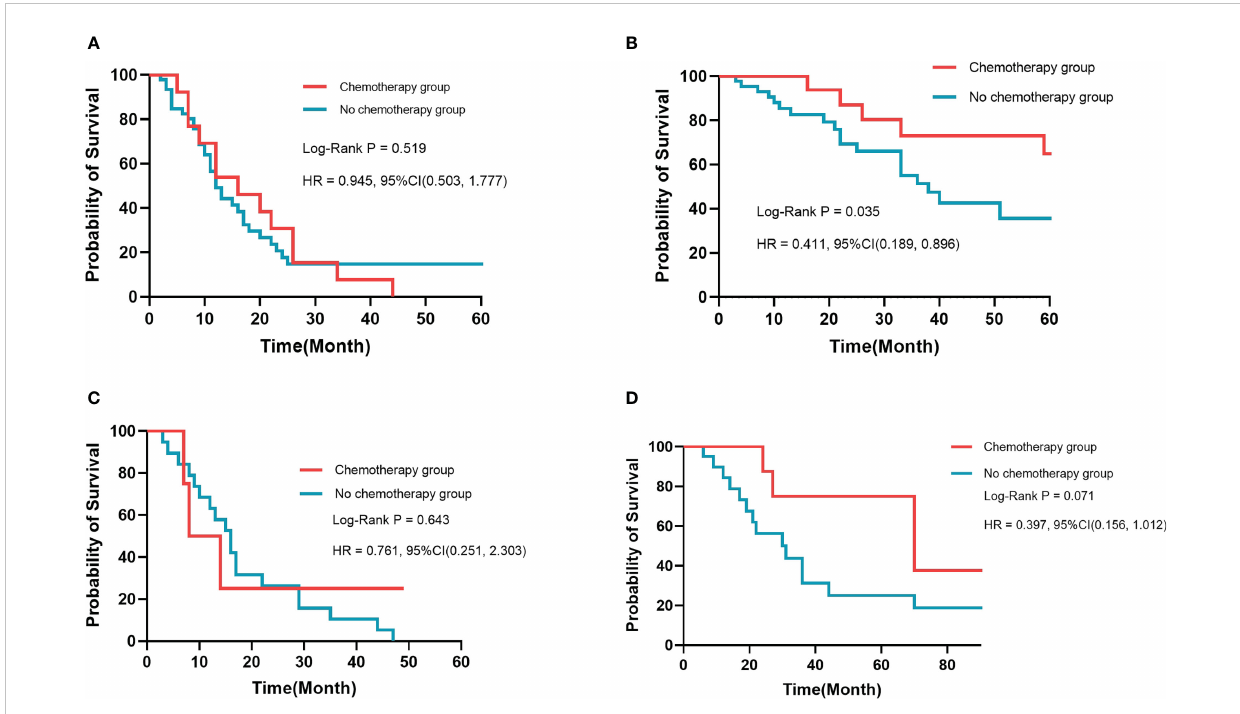
FIGURE 5 Kaplan – Meier survival analysis in different risk groups. There was no signi fi cant difference in prognosis for high-risk patients in the training cohort (A) and the validation cohort (C) . Patients who received chemotherapy had a better prognosis than those who did not in the training cohort (B) and the validation cohort (D)